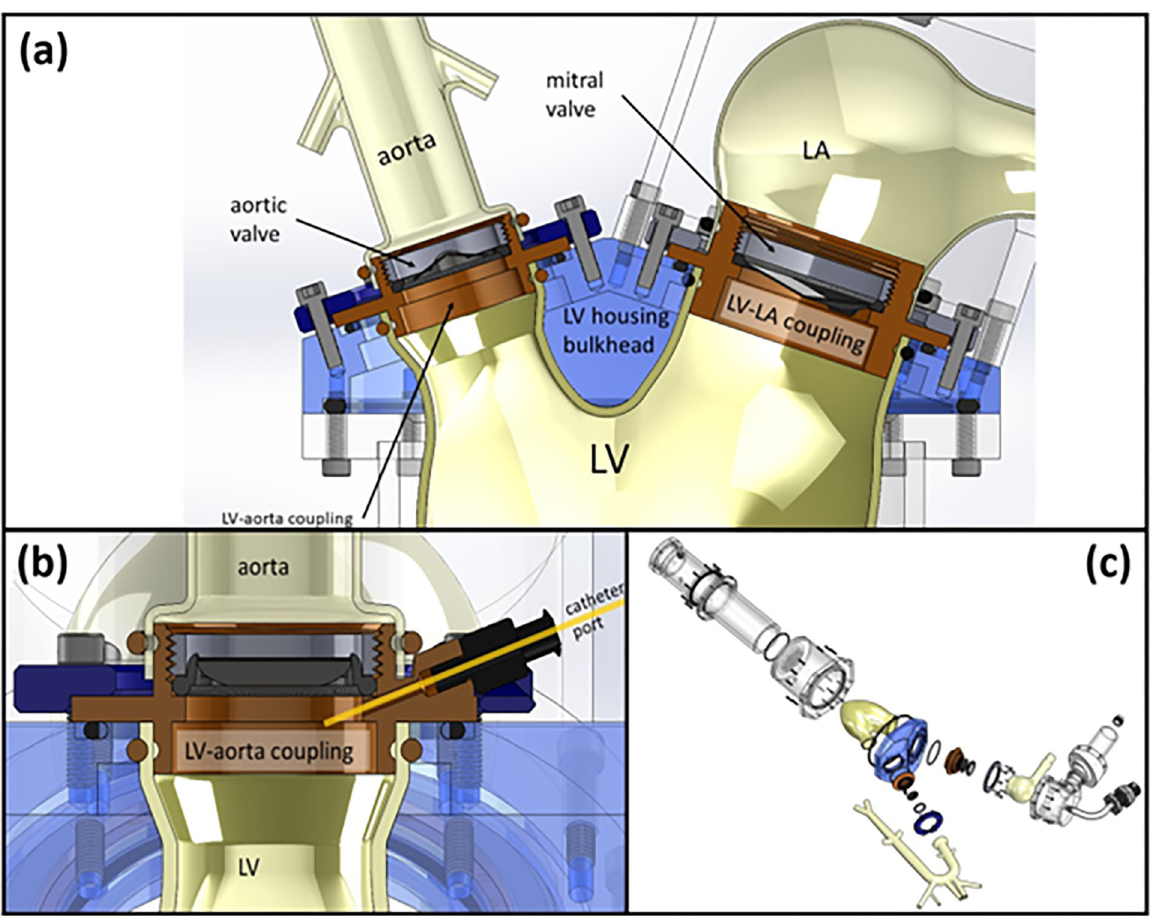
Fig 2. Detailed schematics of the LV-LA and the LV-aorta couplings. (a) Acetal plastic inserts placed in the LV housing bulkhead serve as both LV-LA and LV-aorta couplings as well as housings for their respective mitral and aortic valves. (b) A cross-sectional view of the LV-aorta coupling illustrates how the LV-aorta coupling insert includes a duct through which a catheter may be inserted for LV internal pressure measurements. (c) Exploded view of the setup components corresponding to the LV-aorta and LV-LA coupling mechanisms.